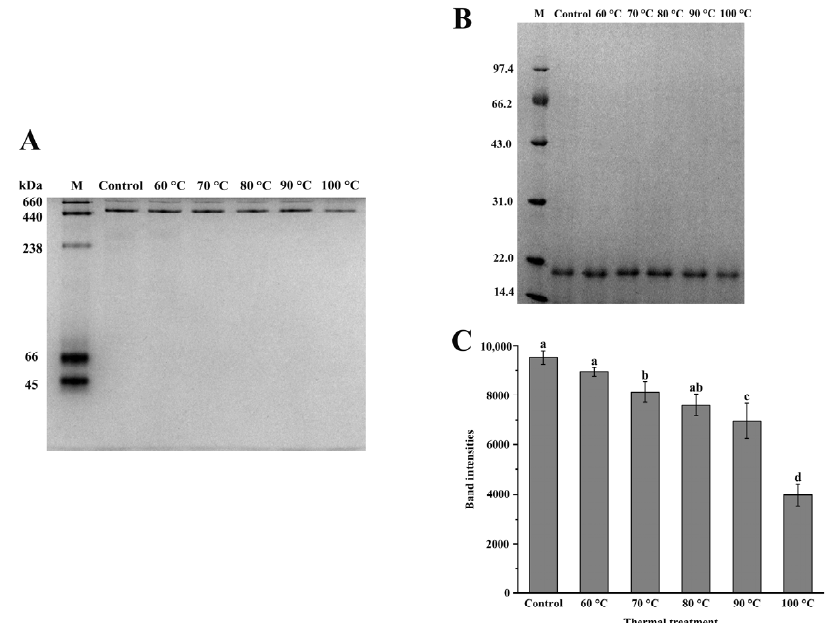
Figure 1. Electrophoresis analyses of northern pike liver (NPLF) at different temperatures. ( A ) Native-PAGE. ( B ) SDS–PAGE. ( C ) Band intensities of NPLF under thermal treatment. Values with different letters are significantly different ( p < 0.05).